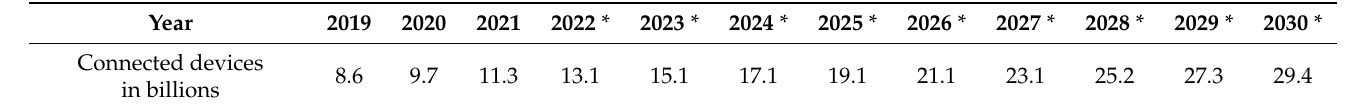
Table 2. Number of Internet of Things (IoT) connected devices worldwide from 2019 to 2021, with forecasts from 2022 to 2030. These statistics are extracted from [42].